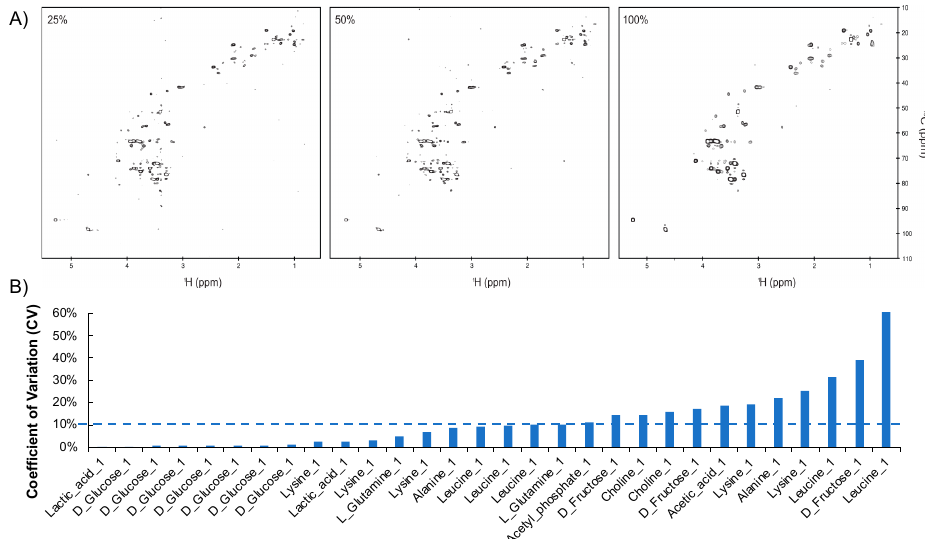
Figure 5. ( A ) NUS HSQC recapitulates US spectra of plasma: Left, 25% NUS (1 h); Middle, 50% NUS (2 h); Right, US (100%) HSQC spectra of an NIST plasma sample. ( B ) Variance of NUS intensity measurements on a plasma sample. %CV of peak intensity in 25% NUS HSQC spectra for select metabolites in the NIST plasma sample. The average CV is provided by the dotted line.